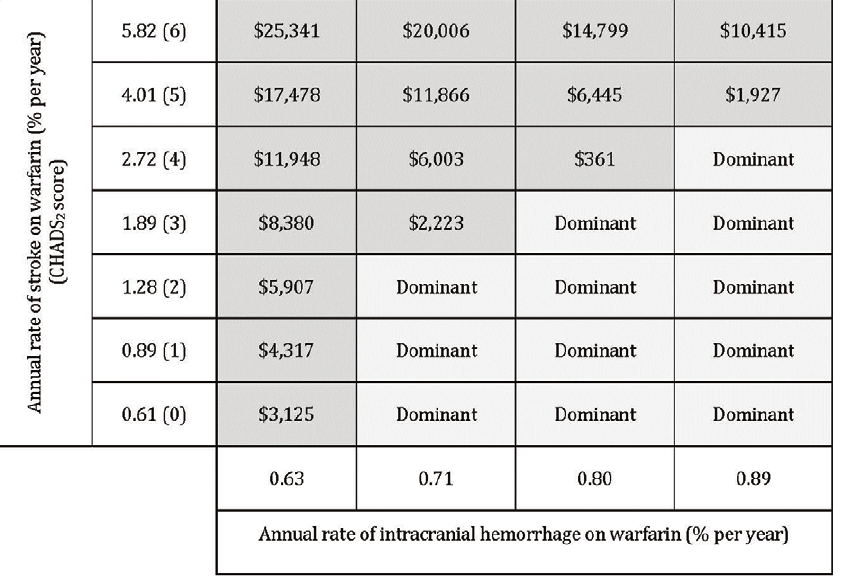
Figure 3. Results of two-way sensitivity analysis. Figure 3 illustrate the different ICERs (cost/QALY) for each combination of values tested for the two parameters (annual rate of intracranial hemorrhage on warfarin and annual rate of stroke on warfarin). Shaded squares represent combinations resulting in positive ICERs and less than $ 50,000 per QALY gained. ICER = incremental cost-effectiveness ratio; QALY = quality- adjusted